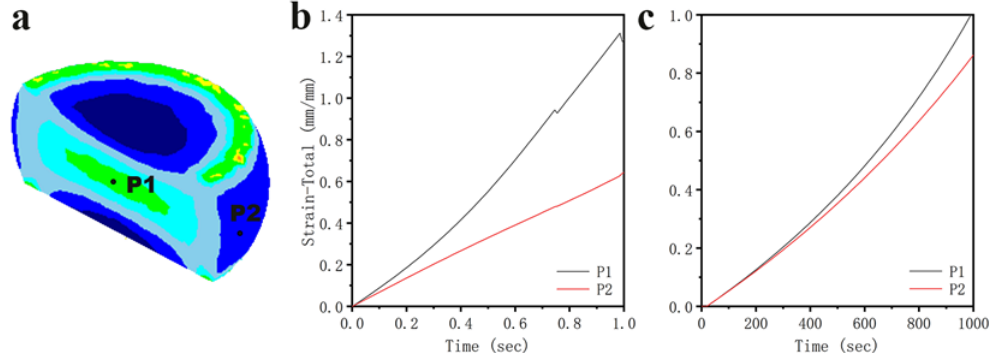
Figure 14. ( a ) Equivalent variation distribution at the end of compression; 700 °C-1 s −1 and ( b ) 900 °C-0.001 s −1 ; ( c ) Changes in the strain values at P1 and P2 during compression, respectively.